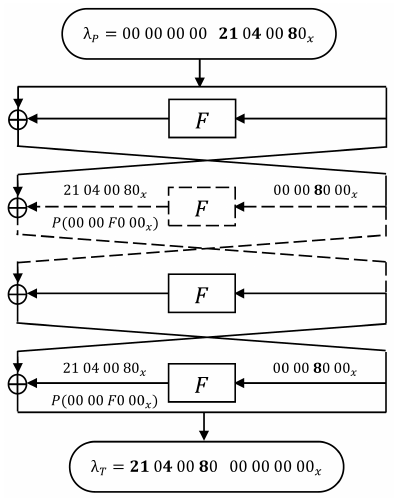
Figure 23: The Scattered approximation λ 14 (4 Rounds of